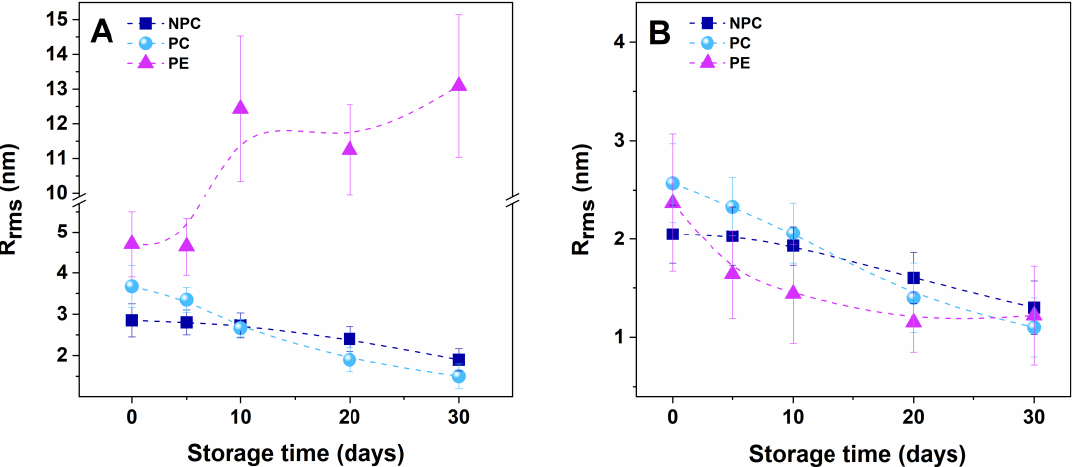
Figure 6. Membrane roughness value (R rms ) determined as a function of storage time for RBCs derived from non-pregnant controls (NPCs), healthy pregnant controls (PCs), and patients with preeclampsia (PE). R rms values were evaluated from topographic images with an area of either 2 × 2 µm 2 ( A ) or 1 × 1 µm 2 ( B ).